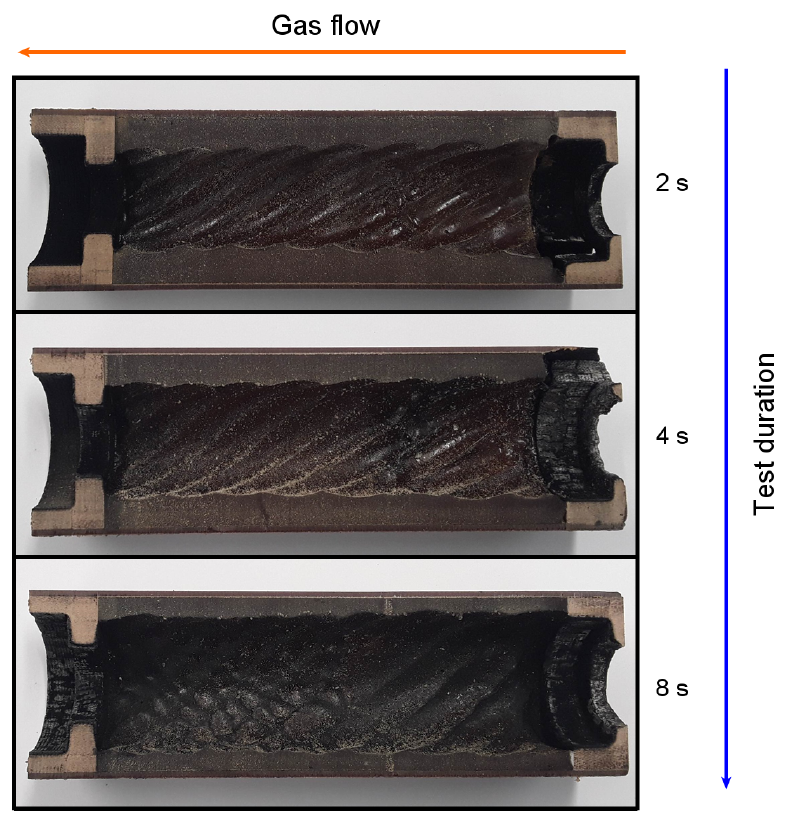
Figure 15. Sectional view of the rotated star fuel blocks after different test times.